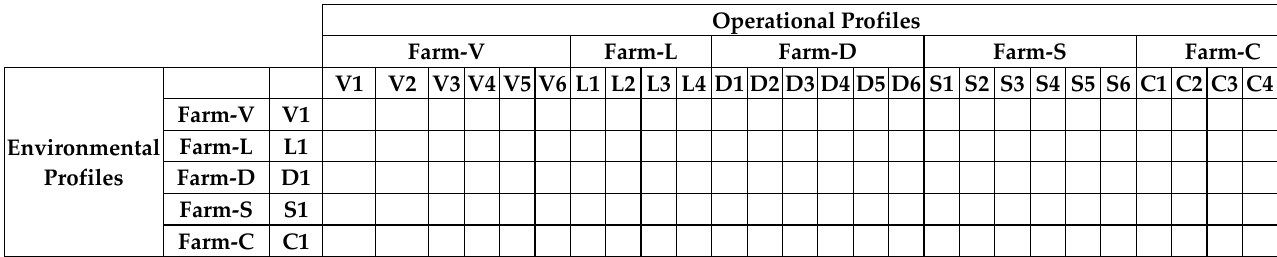
11 of 22 Figure 5. Laminar (𝑃 𝜔 𝑖 = 𝑓 𝑙𝑎𝑚𝑖𝑛𝑎𝑟 (𝜔 𝑖 ) ) and turbulent (𝑃 𝜔 𝑖 = 𝑓 𝑡𝑢𝑟𝑏𝑢𝑙𝑒𝑛𝑡 (𝜔 𝑖 )) power curves and two- state Markov chain state diagram with, e.g., transition matrix for 50% turbulent case. Using this approach, the power data is then simulated using these laminar and tur- bulent power curves. The power produced is computed for each turbine of a wind park. To model the “park effect”, the environmental profile (𝑈(𝑘), 𝑇(𝑘)) used to generate the data is the same for all the turbines of the park. The “ turbulent ” or “ laminar ” state is the same for all the turbines in the park and the switch between turbulent and laminar mode is done at the same time for all the turbines under normal conditions. To model the variability between turbines, the residual added to the power produced is randomly selected from different dispersion matrices, one per each turbine of the park. 4.2. Simulation Protocol For the simulation framework, data from five different wind farms (27 wind turbines) is chosen. These wind farms represent data from a variety of environmental and opera-